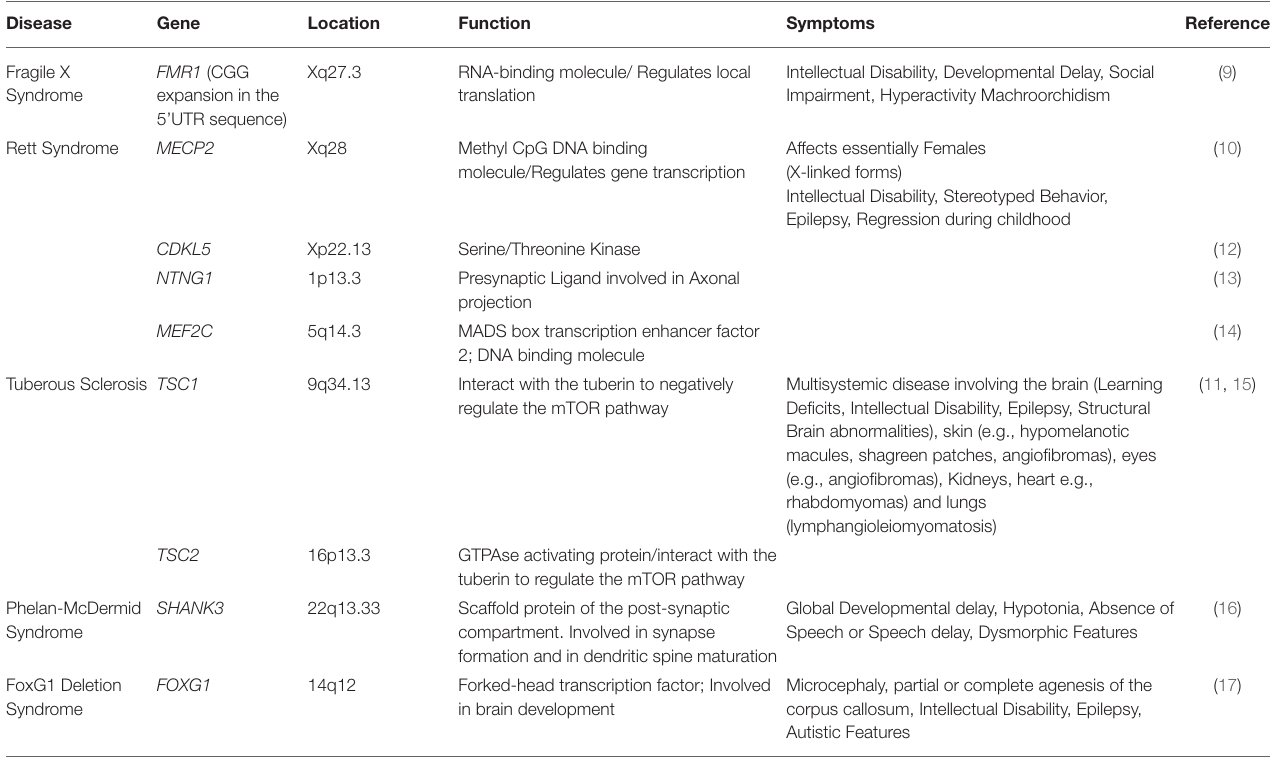
TABLE 1 | Syndromic forms of autism that have been investigated in iPSC-derived studies.